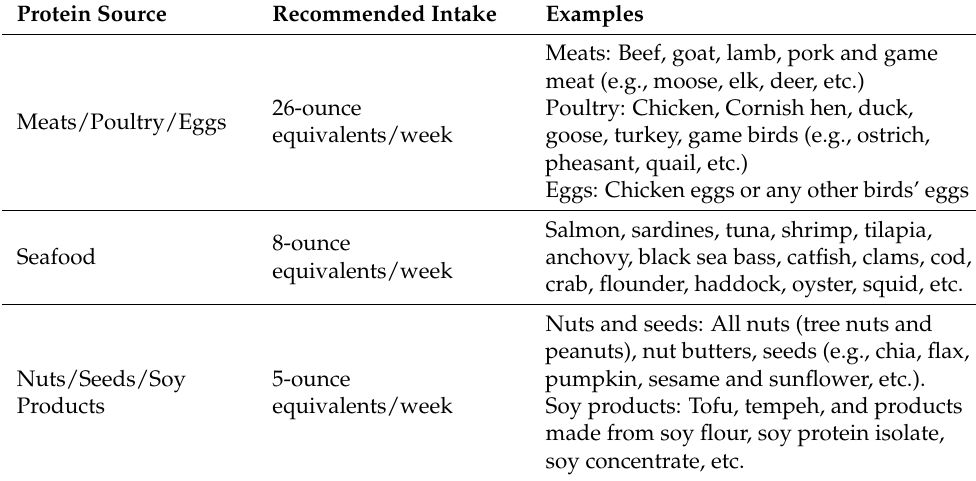
Table 6. MyPlate’s Protein Group with Sources, Examples, and Recommended